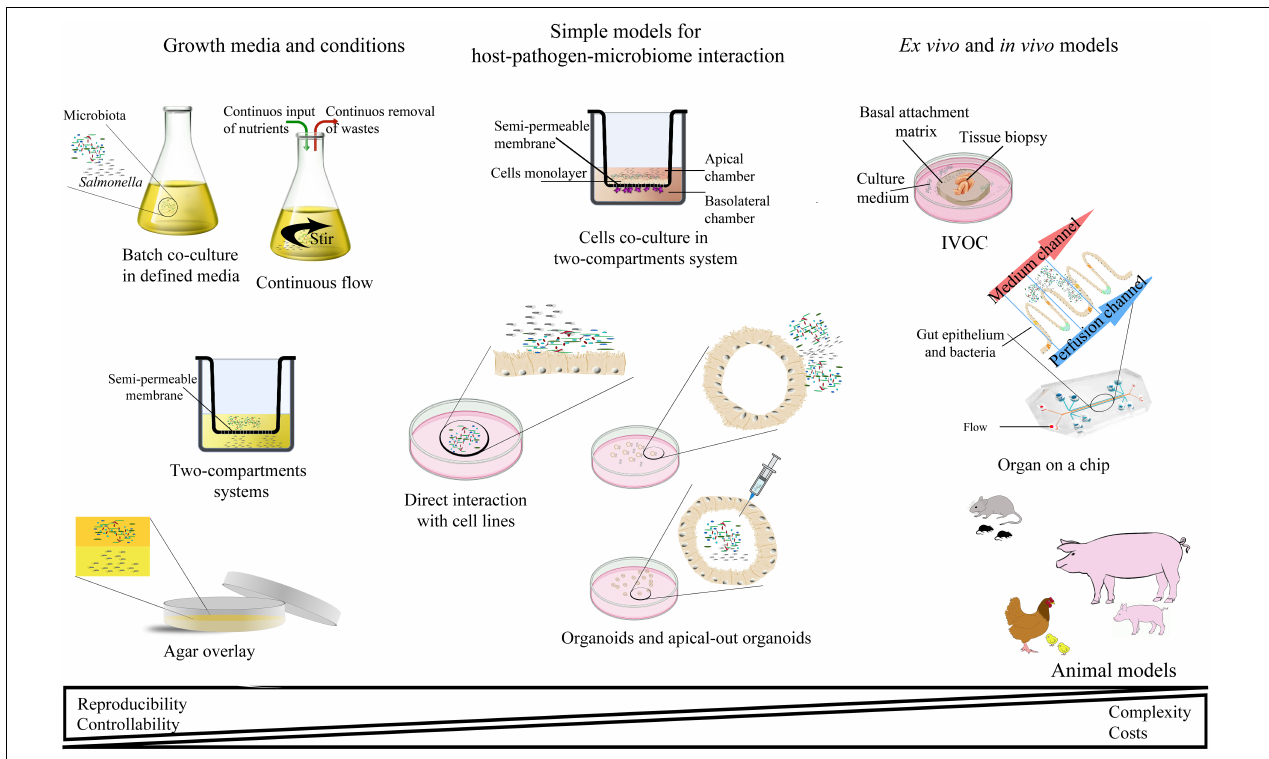
FIGURE 3 | Schematic representation of the most abundant interaction models for studying host–pathogen–microbiota